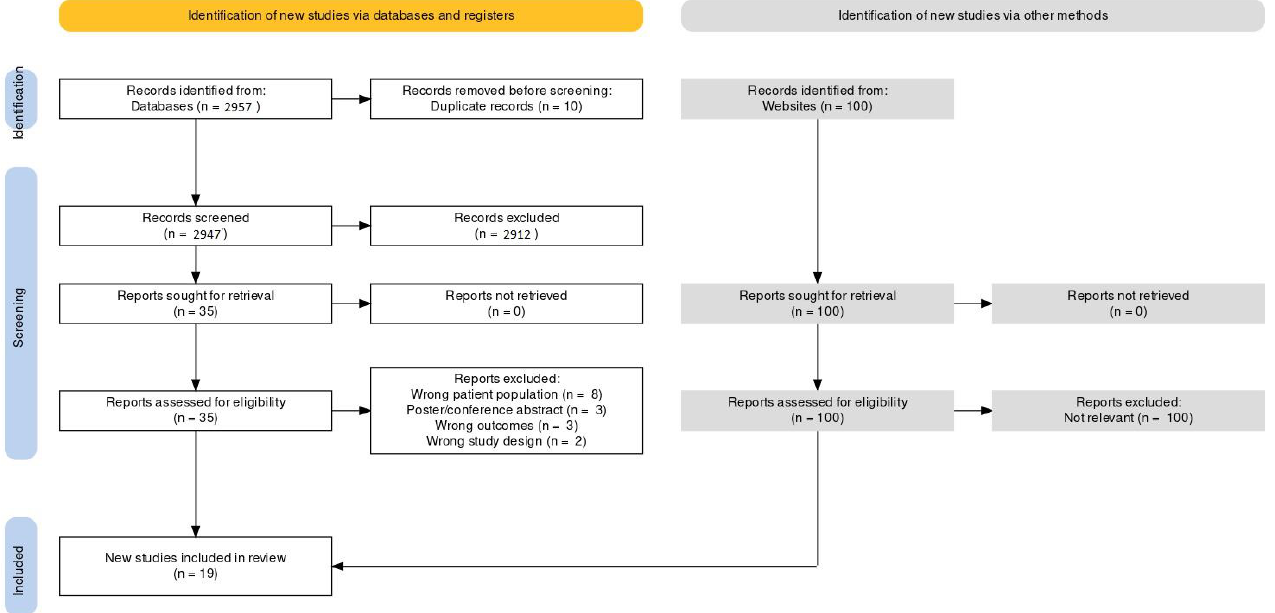
Figure 1. PRISMA flow diagram of search results.